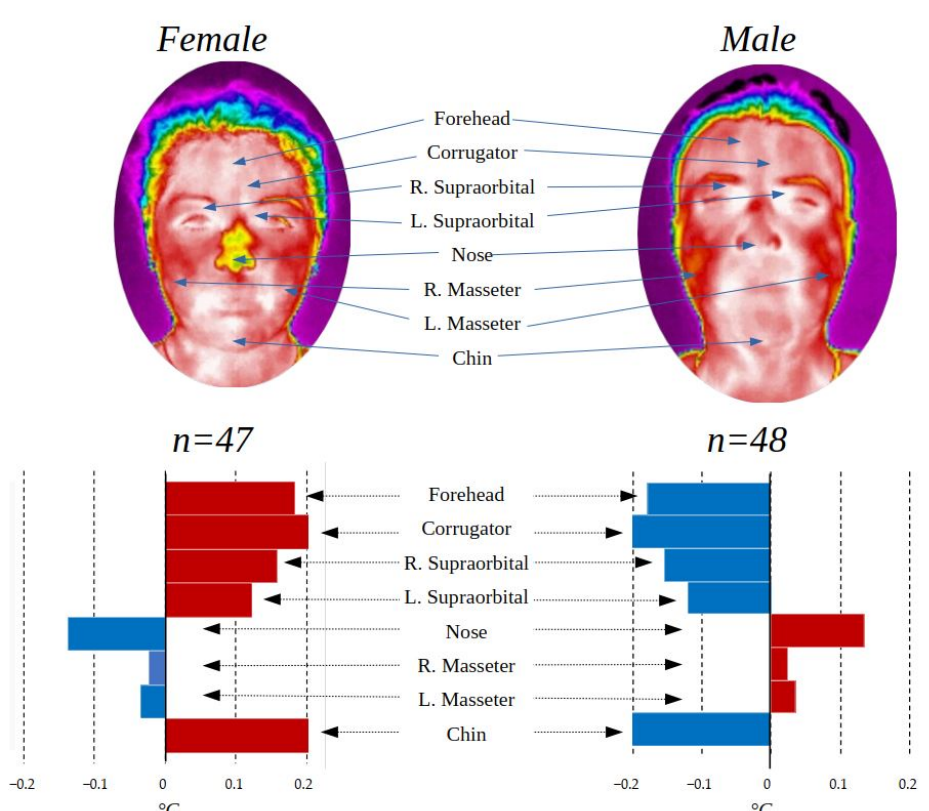
Figure 5. ROI comparison by gender.